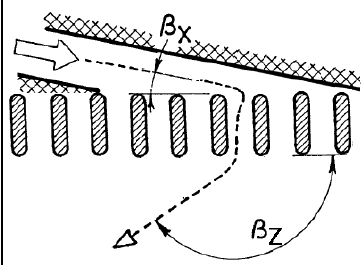
Fig. 9. The configuration of test runs in which, for investigations of the local conditions at the cascade members the jet flows were replaced by well-defined parallel flows in a rectangular channel.